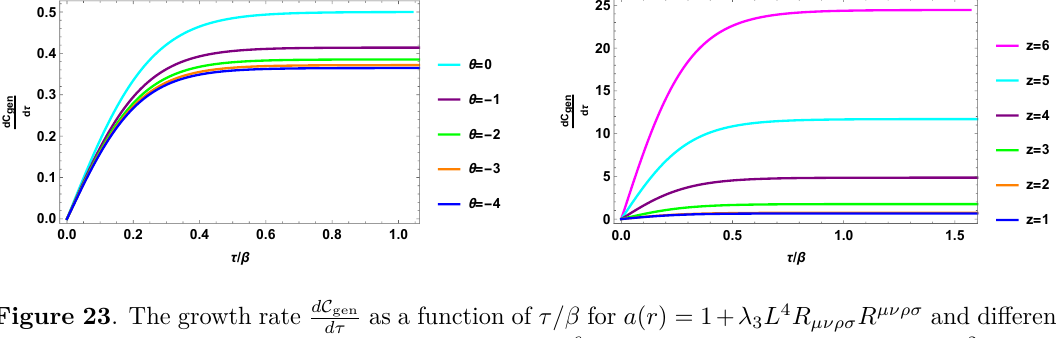
Figure 23 . The growth rate d C gen values of d , θ and z : Left ) d = 1 , z = 1 and λ